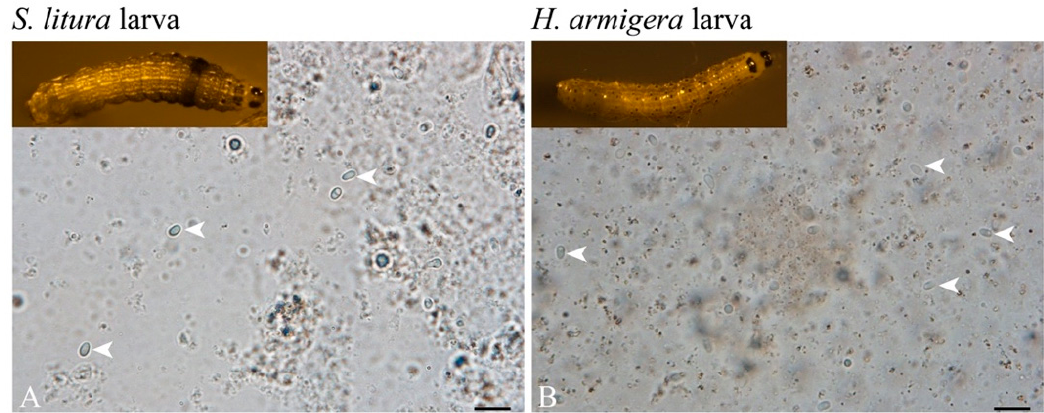
Figure 7. Microscopic observation on the tissue of offspring larvae of S. litura and H. armigera . ( A ) S. litura offspring larvae; ( B ) H. armigera offspring larvae. All bars are 10 μ m, arrowhead shows the NbCQ1 spore.